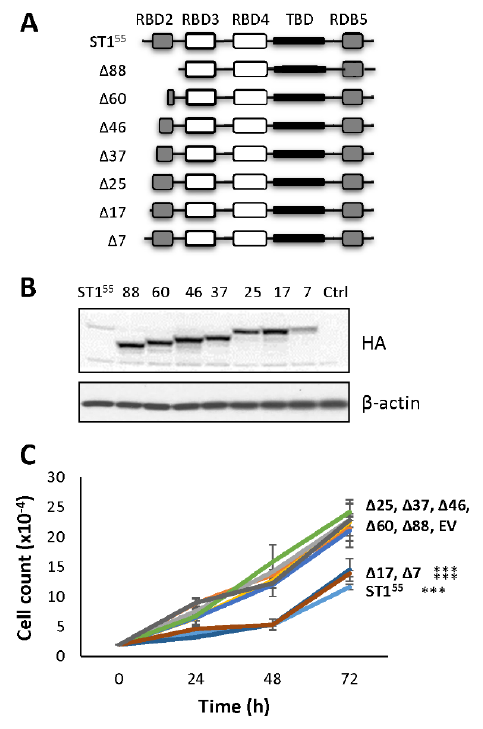
Figure 2. A molecular determinant that controls cell proliferation is present within amino acids 18 and 25. ( A ) Schematic representation of STAU1 55 and STAU1 55 mutants with progressive deletion in the first 88 amino acids at the N-terminal end of STAU1 55 . RBD, RNA-binding domain; TBD, tubulin-binding domain. White boxes, domain with RNA-binding activity; grey boxes, RNA-bind- ing consensus sequence lacking RNA-binding activity; black boxes, tubulin- binding domain. Δx, deletion of x amino acids at the N-terminal end of STAU1 55 . ( B ) Plasmids coding for STAU1 55 and STAU1 55 mutants were transfected in HEK293T cells. At 24 h post-transfection, cells were tryp- sinized, plated at the same density, and allowed to grow for three days. Expression of the proteins was visualized by western blotting. The blots are representative of three independent experiments that gave similar results. ( C ) Cell proliferation using growth curve assays was quantified over three days. The graph represents the means and standard deviations of three independently performed experiments. ***, p - value ≤ 0.001 (Tukey’s multiple comparisons ANOVA test). 2.3. Phosphomimicry on S20 and T21 Controls Cell Proliferation Remarkably, four of the eight amino acids in the 18 – 25 amino acid sequence were putative targets for phosphorylation, MQS 20 T 21 Y 22 NY 24 N. To determine if phosphorylation events could be involved in the STAU1 55 -dependent impairment of cell proliferation, we generated phosphomimetic and non-phosphorylatable mutants for each of these residues and determined the impact of these modifications on cell proliferation using the growth curve assay (Figure 3). Each mutant was transfected in HEK293T cells, and western blot- ting was performed to confirm their expression (Figure 3A). The expression of the phos- phomimetic S20D mutant impaired cell proliferation (Figure 3B). In contrast, cells trans- fected with the non-phosphorylatable S20A mutant grew normally. The opposite effect was observed following the expression of the T21 mutants (Figure 3C). The non-phos- phorylatable T21A mutant impaired cell proliferation, as did the wild-type protein. Cells